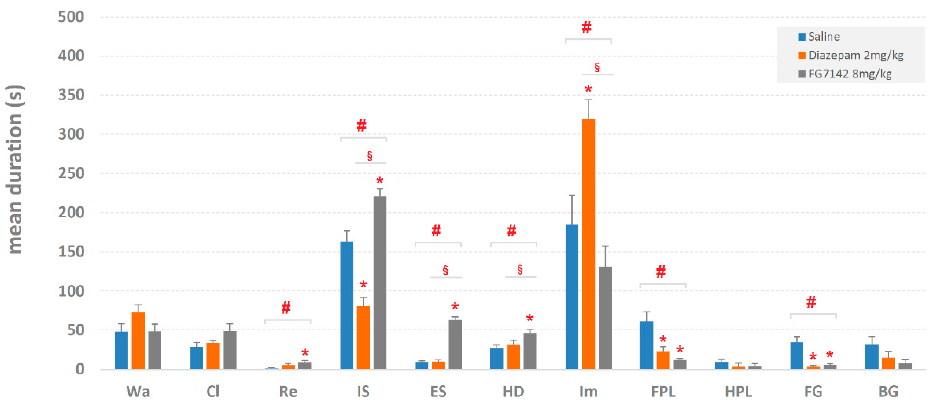
Figure 3. Mean duration ± SEM (in s) of each component of the behavioral repertoire (see Figure 1) in saline, diazepam 2 mg/kg and in FG7142 8 mg/kg groups. # = statistically significant ( p < 0.05) ANOVA result; * = significant ( p < 0.05) difference of diazepam or FG7142 groups in comparison with saline group (Newman–Keuls post-hoc test for multiple comparisons); § = significant ( p < 0.05) difference between diazepam and FG7142 groups (Newman–Keuls post-hoc test for multiple comparisons). Data obtained from the analysis of three groups each encompassing 10 subjects. See Figure 1 for abbreviations.